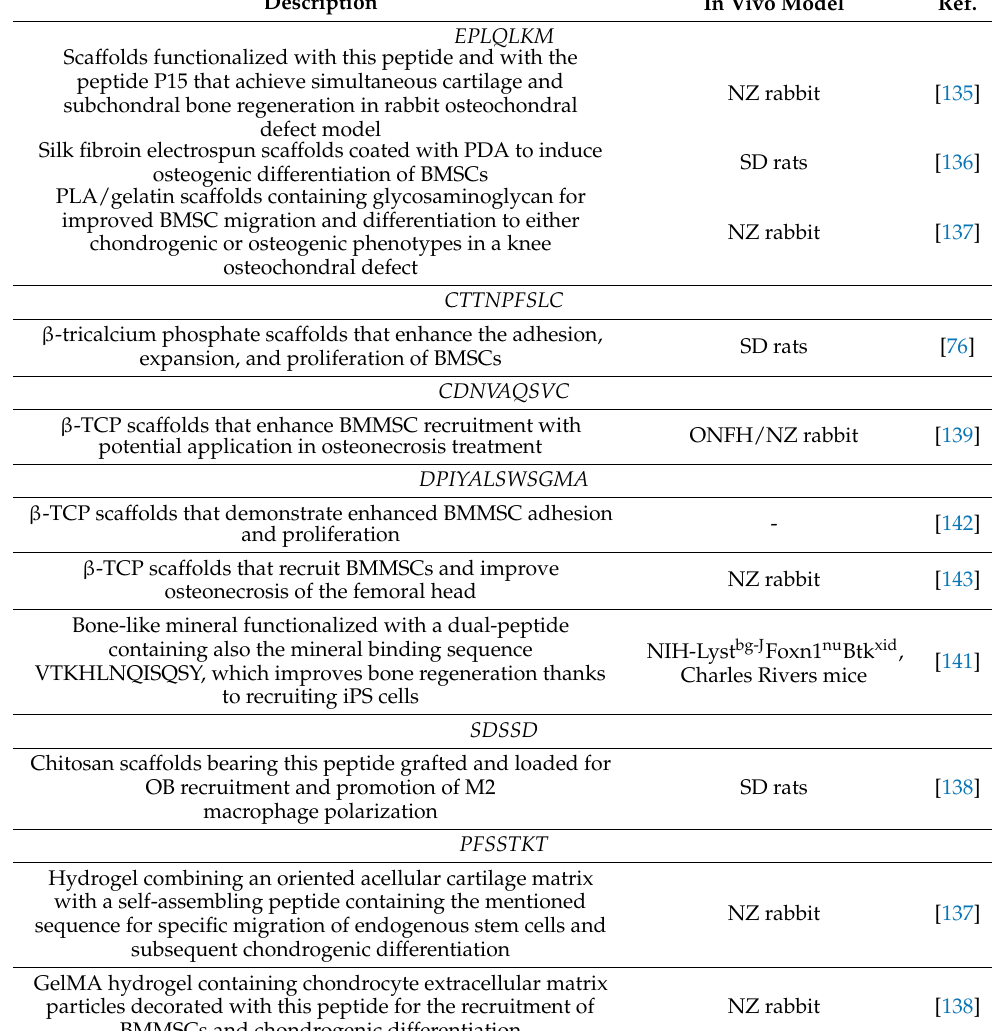
Table 3. Summary of the research articles that describe the use of phage-display-peptide-decorated scaffolds for bone